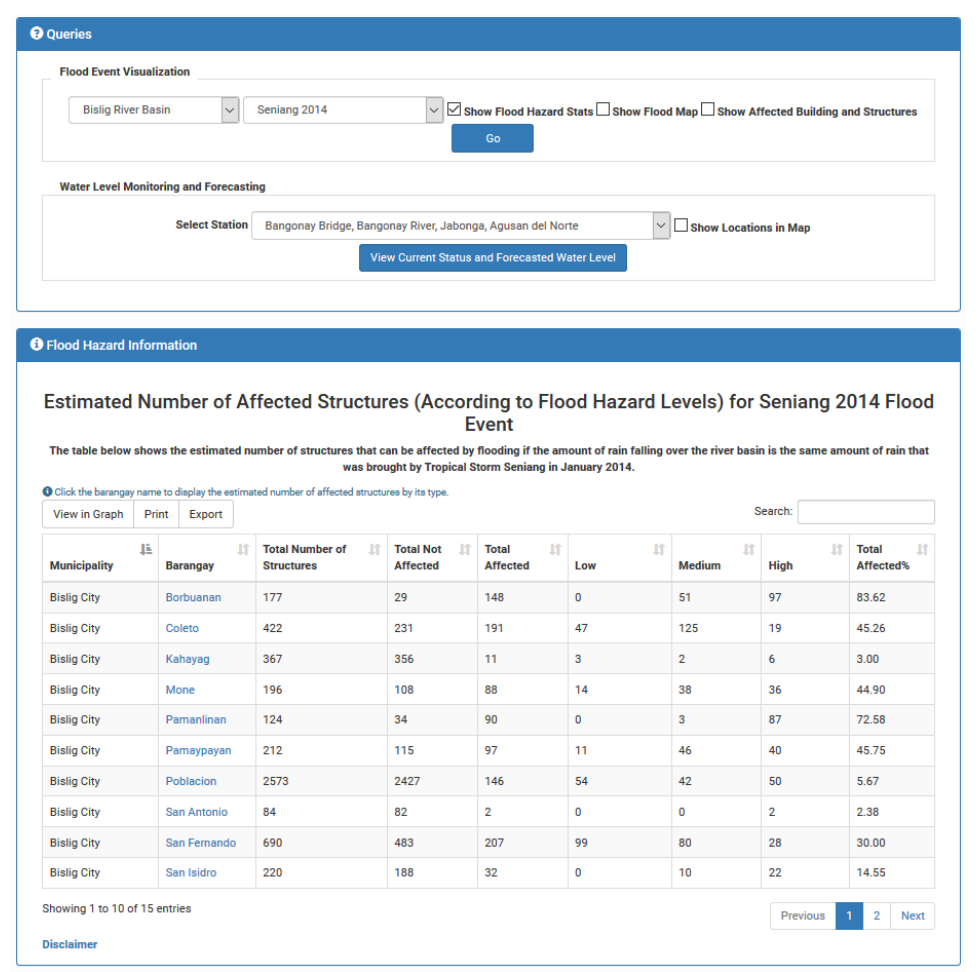
Figure 6. A table containing the total number of affected structures per barangay according to hazard level that is generated when Flood EViDEns is used to generated hazard statistics.